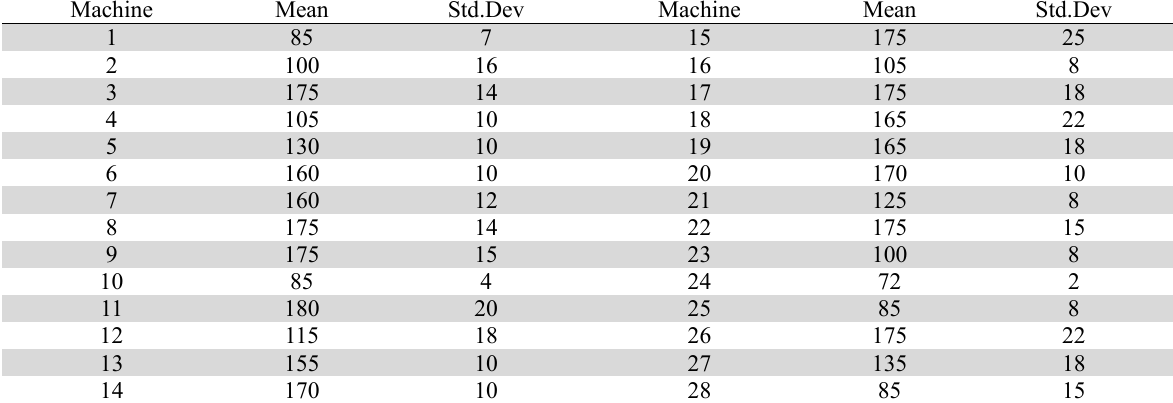
The distributional parameters of processing times for Case 2.